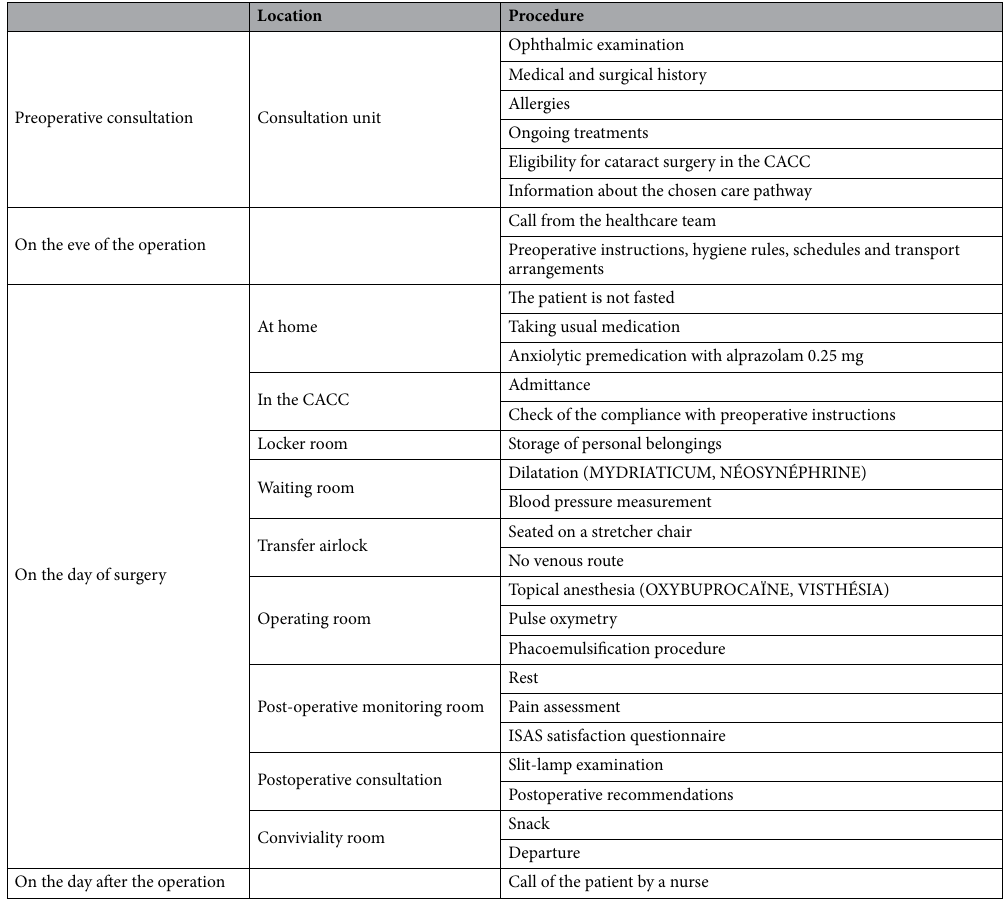
Table 1. Patient care from the preoperative consultation until the day after the